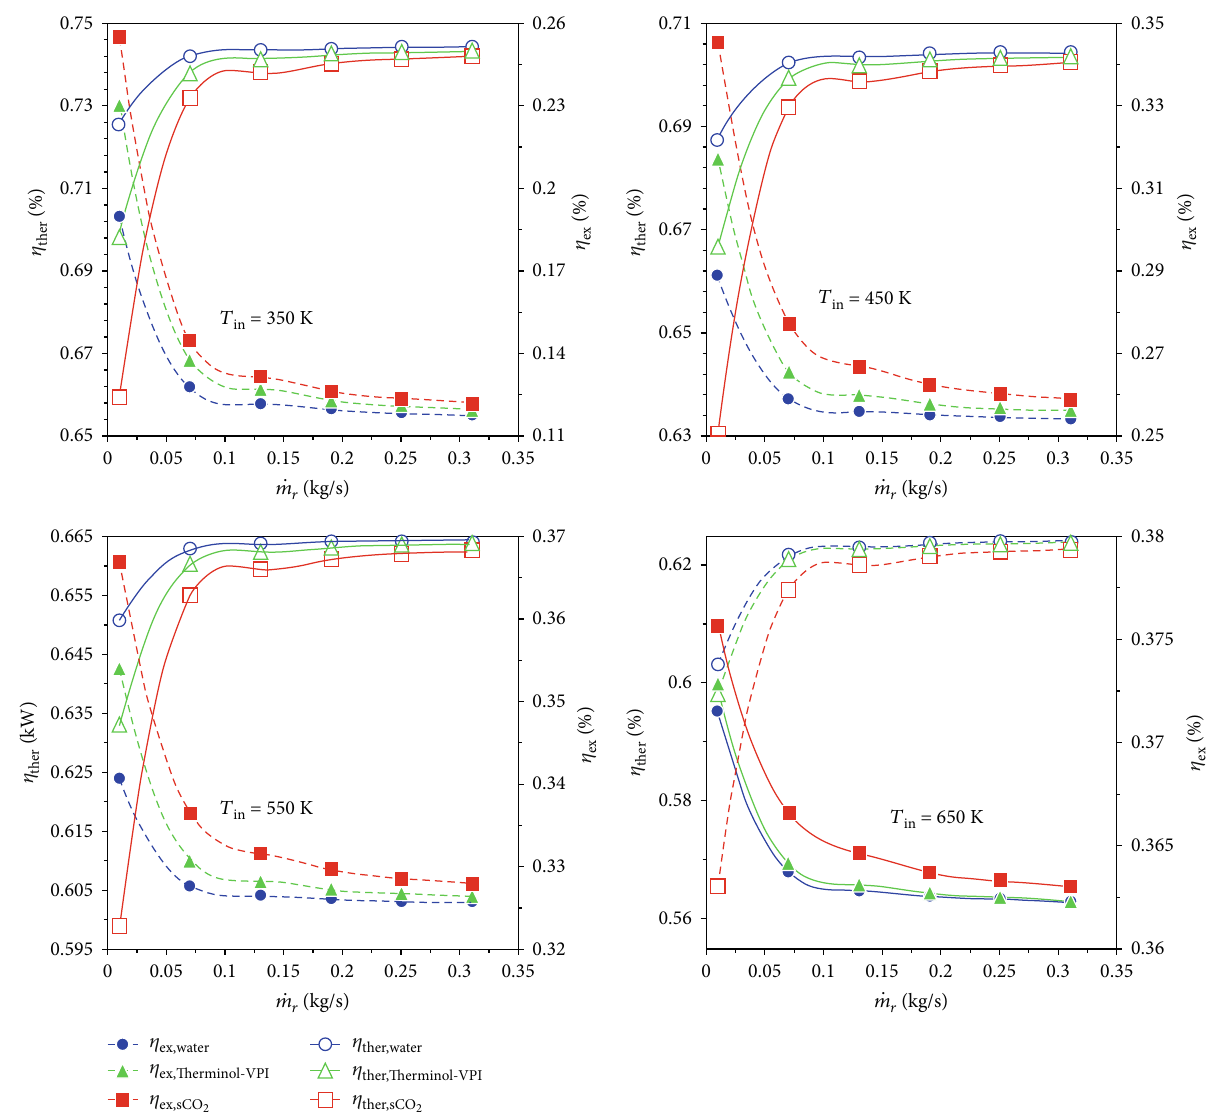
Figure 4: E ff ect of mass fl ow rate on the thermal and exergy e ffi ciencies for various inlet temperature